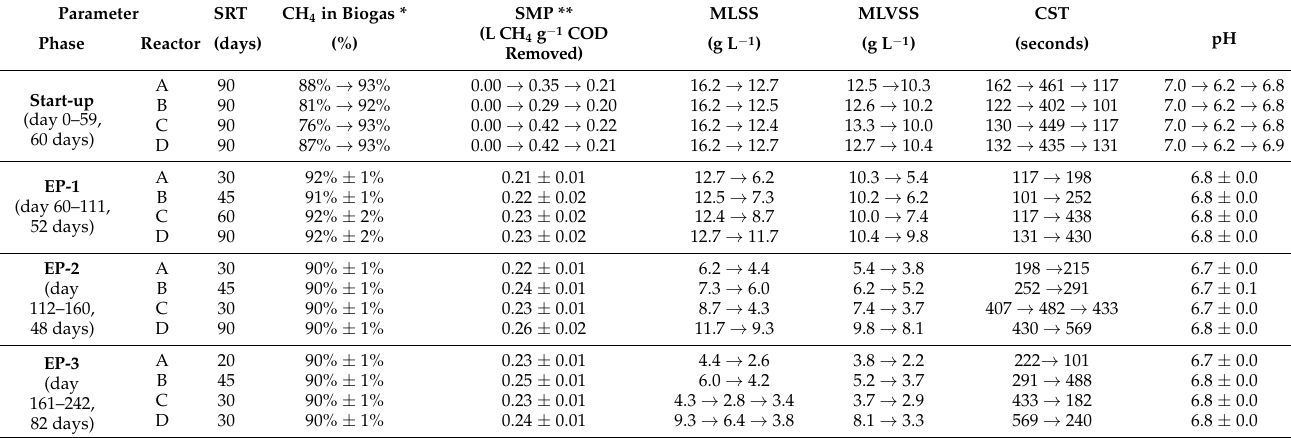
Table A2. Experimental results; SRT effect on: CH 4 content in biogas, SMP, MLSS, MLVSS, CST and